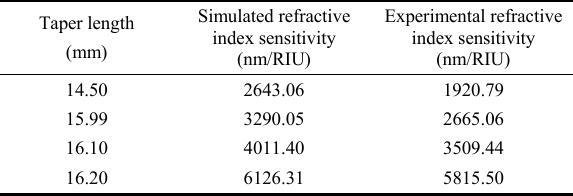
Table 1 Comparison of simulation results and experimental results under different taper lengths.